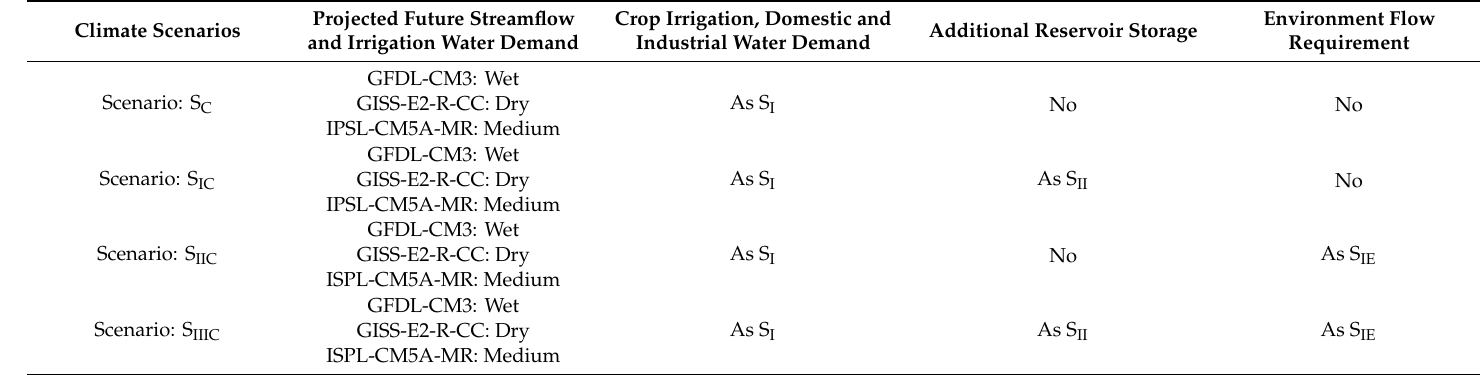
Table 6. The descriptions of Climate Change